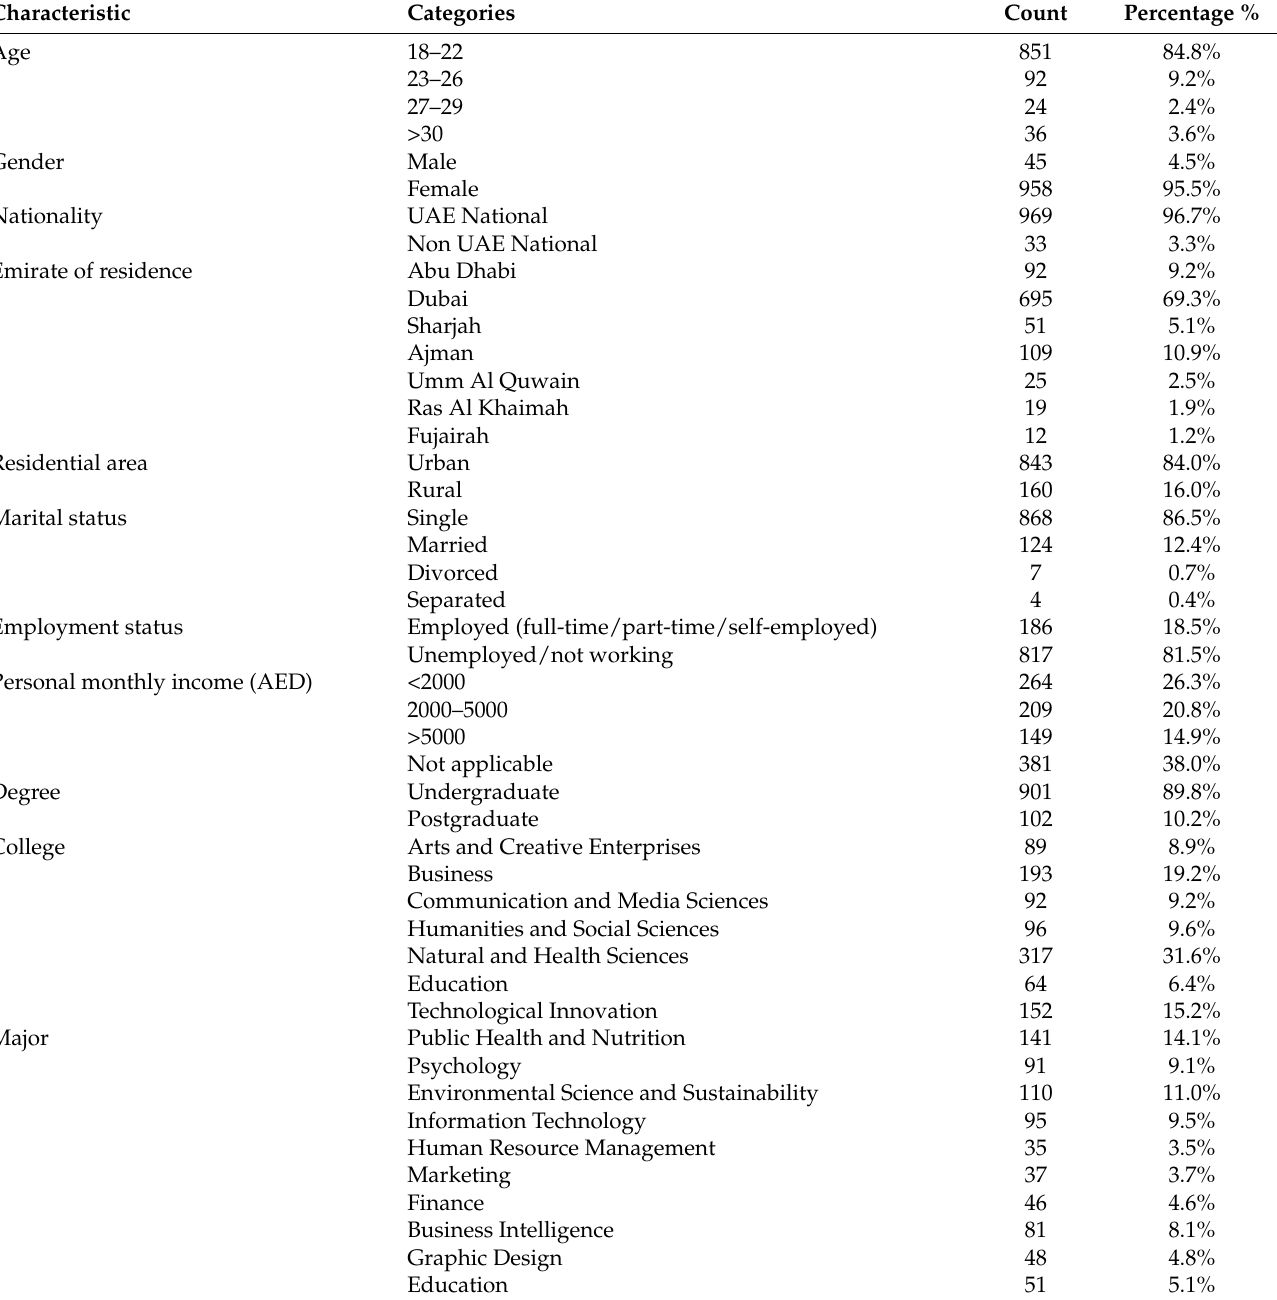
Table 2. Demographic information of the participants (n =